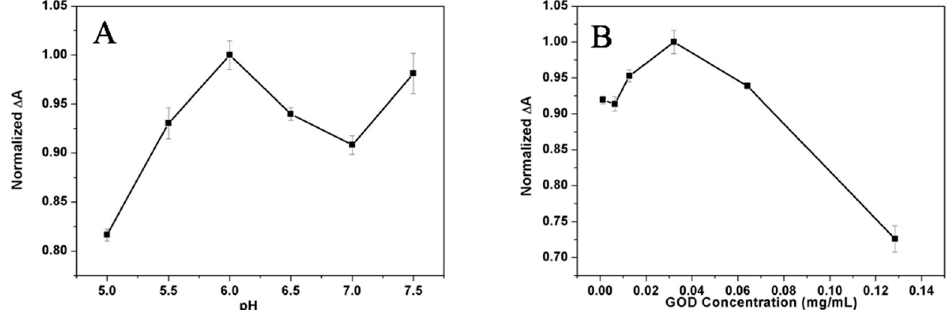
Figure 3. Effects of pH of the assay on detecting 50 μ M glucose ( A ), and effects of the concentration of GOD on detecting 0.2 mM glucose ( B ) at 346 nm. Note: Error bars represented the SDs from three independent detections.